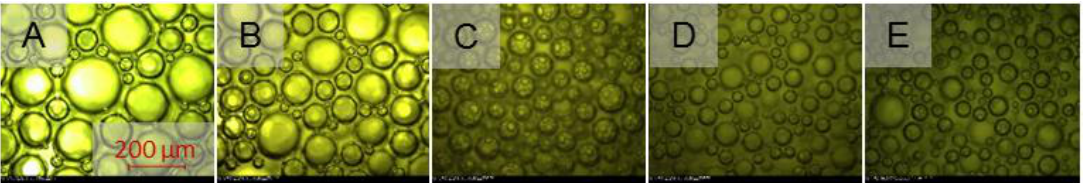
Figure 5. Liquid polysorbate 80 foam with maltodextrin concentrations of ( A ) 20, ( B ) 25, ( C ) 30, ( D ) 35 and ( E ) 40% using transmitted light. The scale bar in ( A ) can also be applied to ( B ) – ( E ).